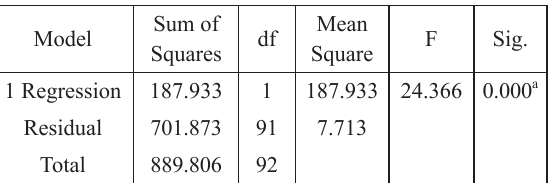
One Way ANOV for Resistance, Complexity, Relative